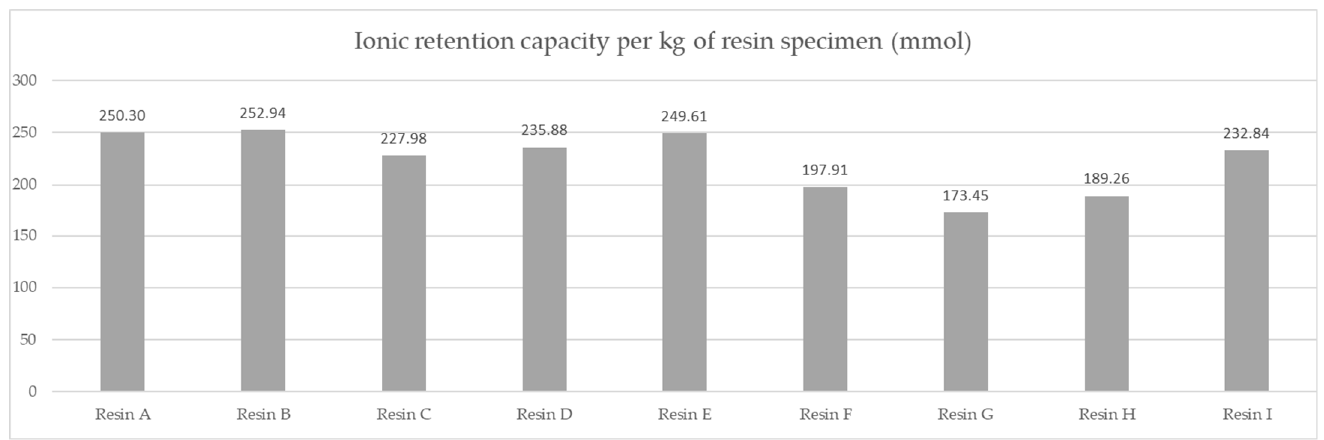
Figure 7. Comparison of average molar capacity in given test conditions of the resin products.